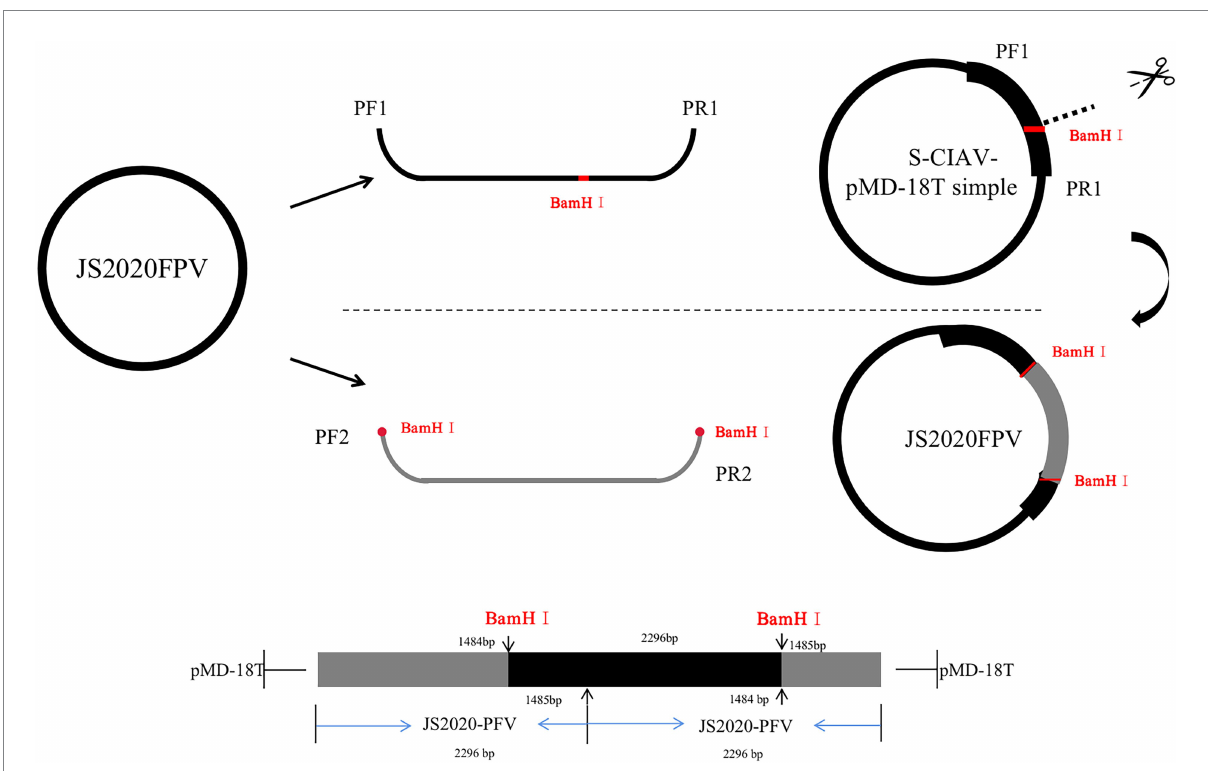
FIGURE 1 Schematic showing construction of the JS2020-PFV double-copies infectious clone. Primers PF1/R1 were used to amplify the single-copy clone. S-JS2020-PFV was digested with the BamH I endonuclease. The amplification product of PF2/R2 was inserted into the gap through homologous recombination to construct the JS2020-PFV double-copies infectious clone.